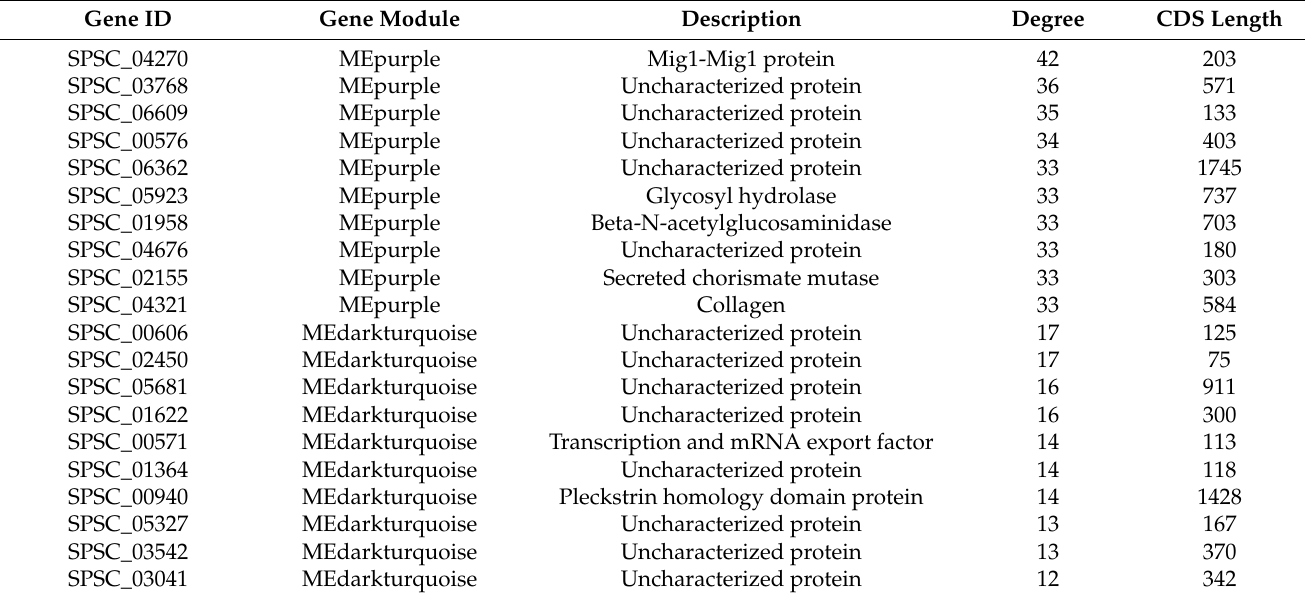
Figure 5. The top ten hub genes in the MEpurple and MEdarkturquoise modules. Co-expression networks of the top ten hub genes in the ( A ) MEpurple and ( B ) MEdarkturquoise modules and the details of hub genes were shown in Table 2. The hub genes were mined using the Cytohubba plugin in the Cytoscape v3.9.1 (Paul Shannon, Seattle, WA, USA). The cells are color-coded by degree (higher degree = cells with darker red color). Degree represents the number of connections at this gene according to co-expression analysis. Expression profiles of the top ten hub genes in the ( C ) MEpurple and ( D ) MEdarkturquoise modules. The RPKM were standardized by rows into fractions (0 to 1) for better visualization. The red arrows indicate the predicted small secreted cysteine-rich proteins (SCRPs). The blue arrows indicate proteins identified in the pathogen – host interactions (PHI) database. Table 2. Top ten hub genes in the MEpurple and MEdarketurquoise modules.